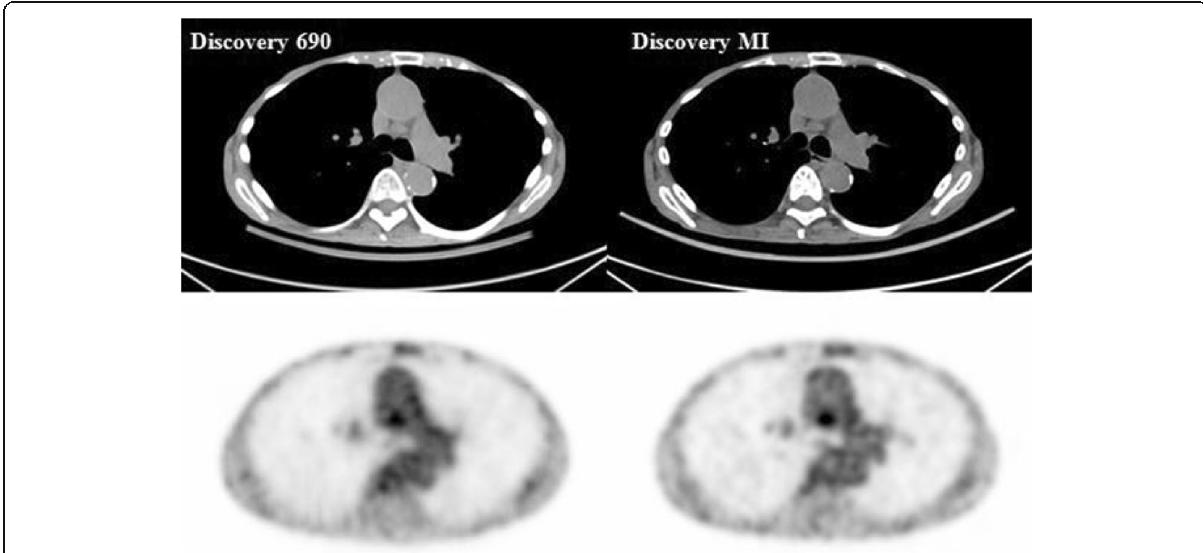
Fig. 1 Axial PET and CT images. An example of axial PET and CT images of a mediastinal lymph node with a SUV max of 2.7 on the Discovery 690 and 3.6 on the Discovery MI